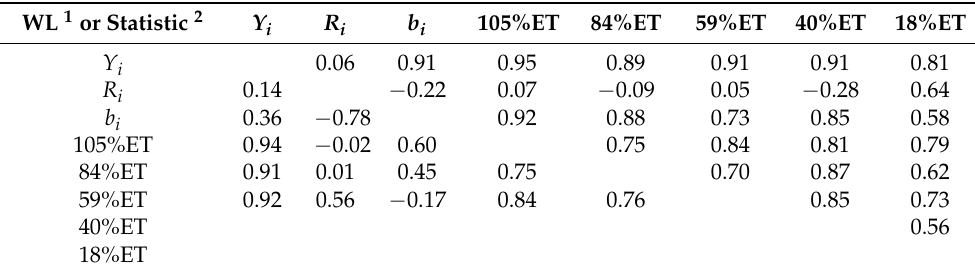
Table 4. Genetic correlations among water levels (% ET replacement) and yield statistics for 28 tall fescue half-sib families evaluated for forage mass in a line-source irrigation experiment with 5 water levels (WL) from 2001 to 2003 near Logan, UT, USA. The top diagonal is for the seasonal total forage mass model, whereas the bottom diagonal is for analysis across five repeated